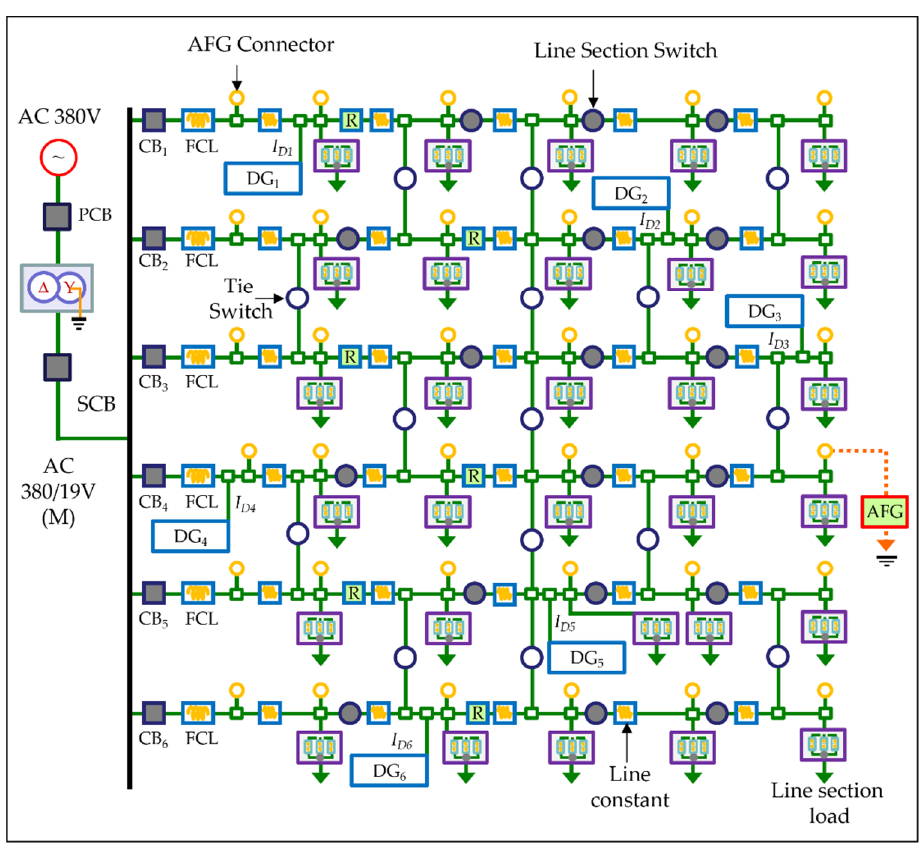
Figure 3. Configuration of the micro SG simulator.